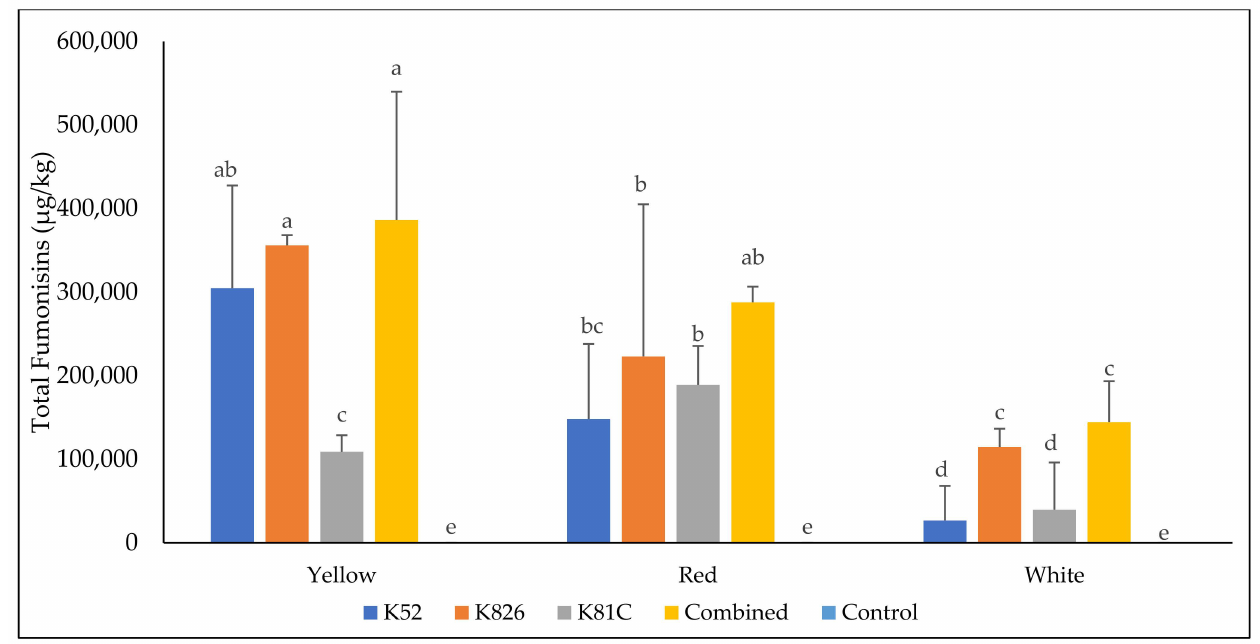
Figure 1. Total fumonisin (FB1, FB2, FB3) production in maize media after 21 days of inoculation with different F. verticillioides strains and incubated in chambers fitted with white, red, or yellow lights. Values are the means of three replicates ± standard deviation. Means with different letters are significantly different ( p < 0.05) according to the post hoc Dunn